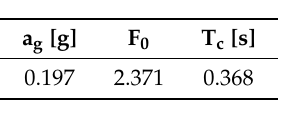
Table 3. Ground shaking parameters for the historical center of Avellino for a return period of 475 years.